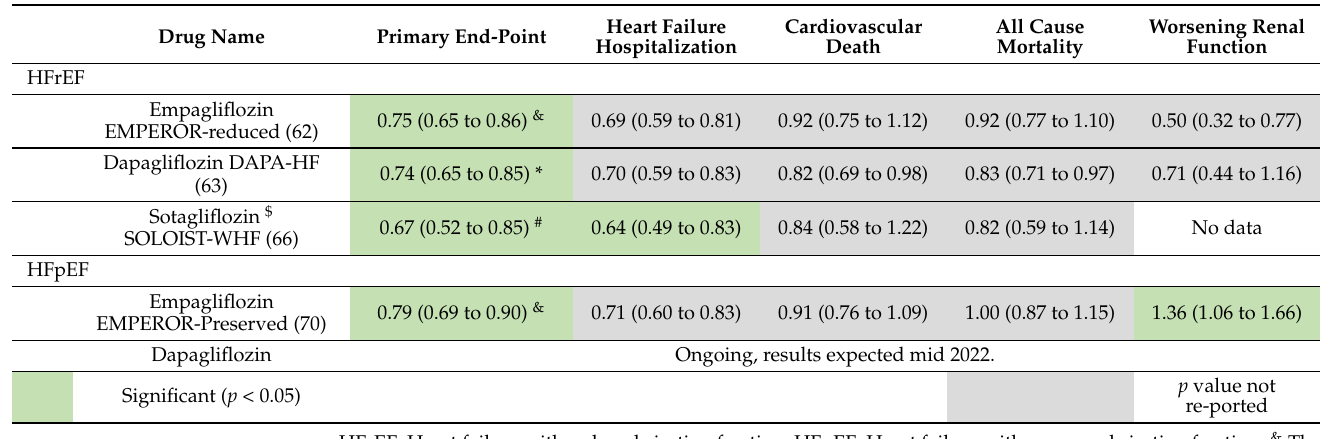
Figure 1. The various indications as well upcoming and future perspectives for novel diabetes medications for the cardiovascular patients, for both diabetic as well as non-diabetic, patients. ACS = Acute Coronary Syndrome; ASCVD = Atherosclerotic Cardiovascular Disease; GLP-1RA = Glucagon-like peptide-1 Receptor Agonists; HF = Heart Failure; HFrEF = HF with reduced Ejection Fraction; HfpEF = HF with preserved Ejection Fraction; SGLT2i = Sodium-glucose cotransporter 2 inhibitor. Table 3. Major clinical outcomes from heart failure studies evaluating SGLT2i.